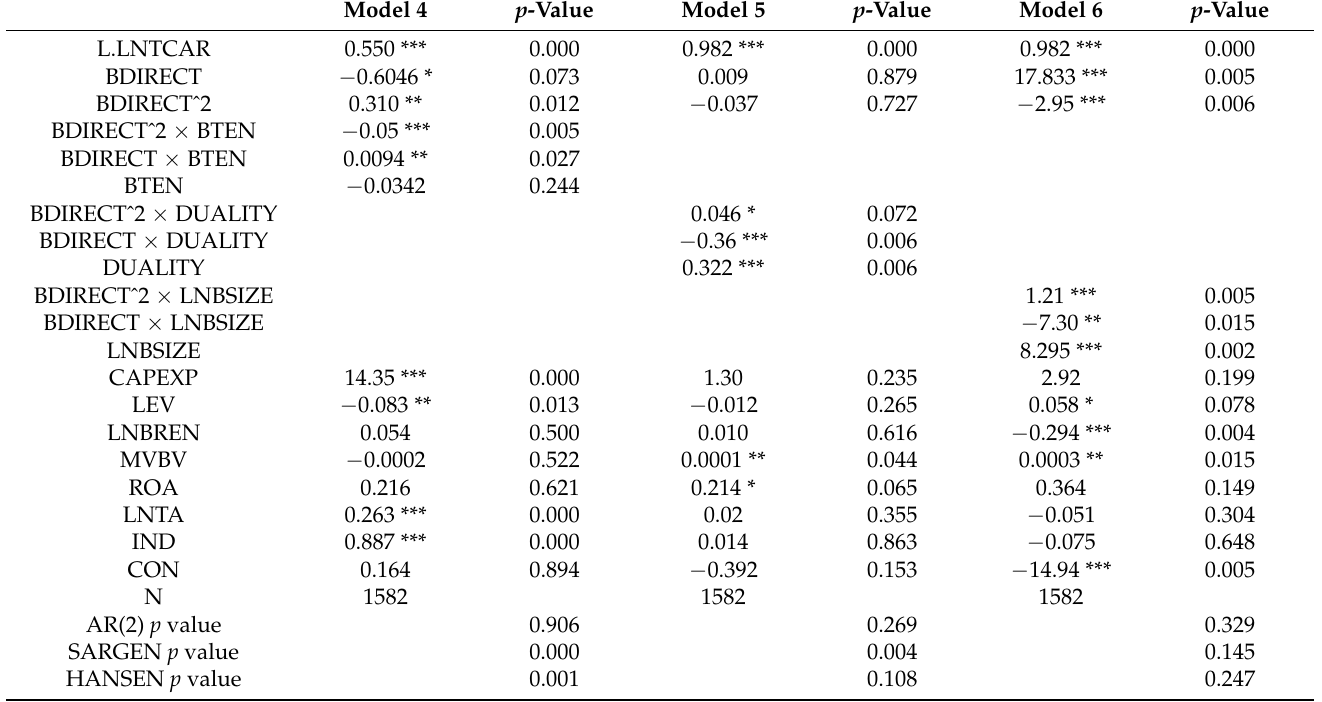
Table 5. Main results: two-step GMM regression for Models 4, 5, and 6.